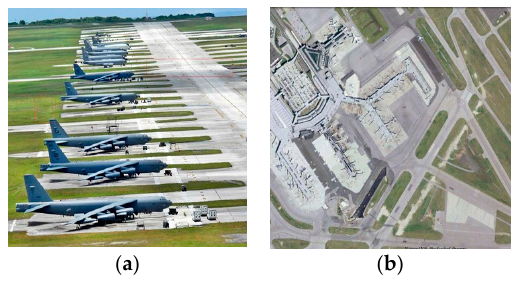
Figure 5. Airport in: ( a ) daily nature image; and ( b ) remote sensing image.